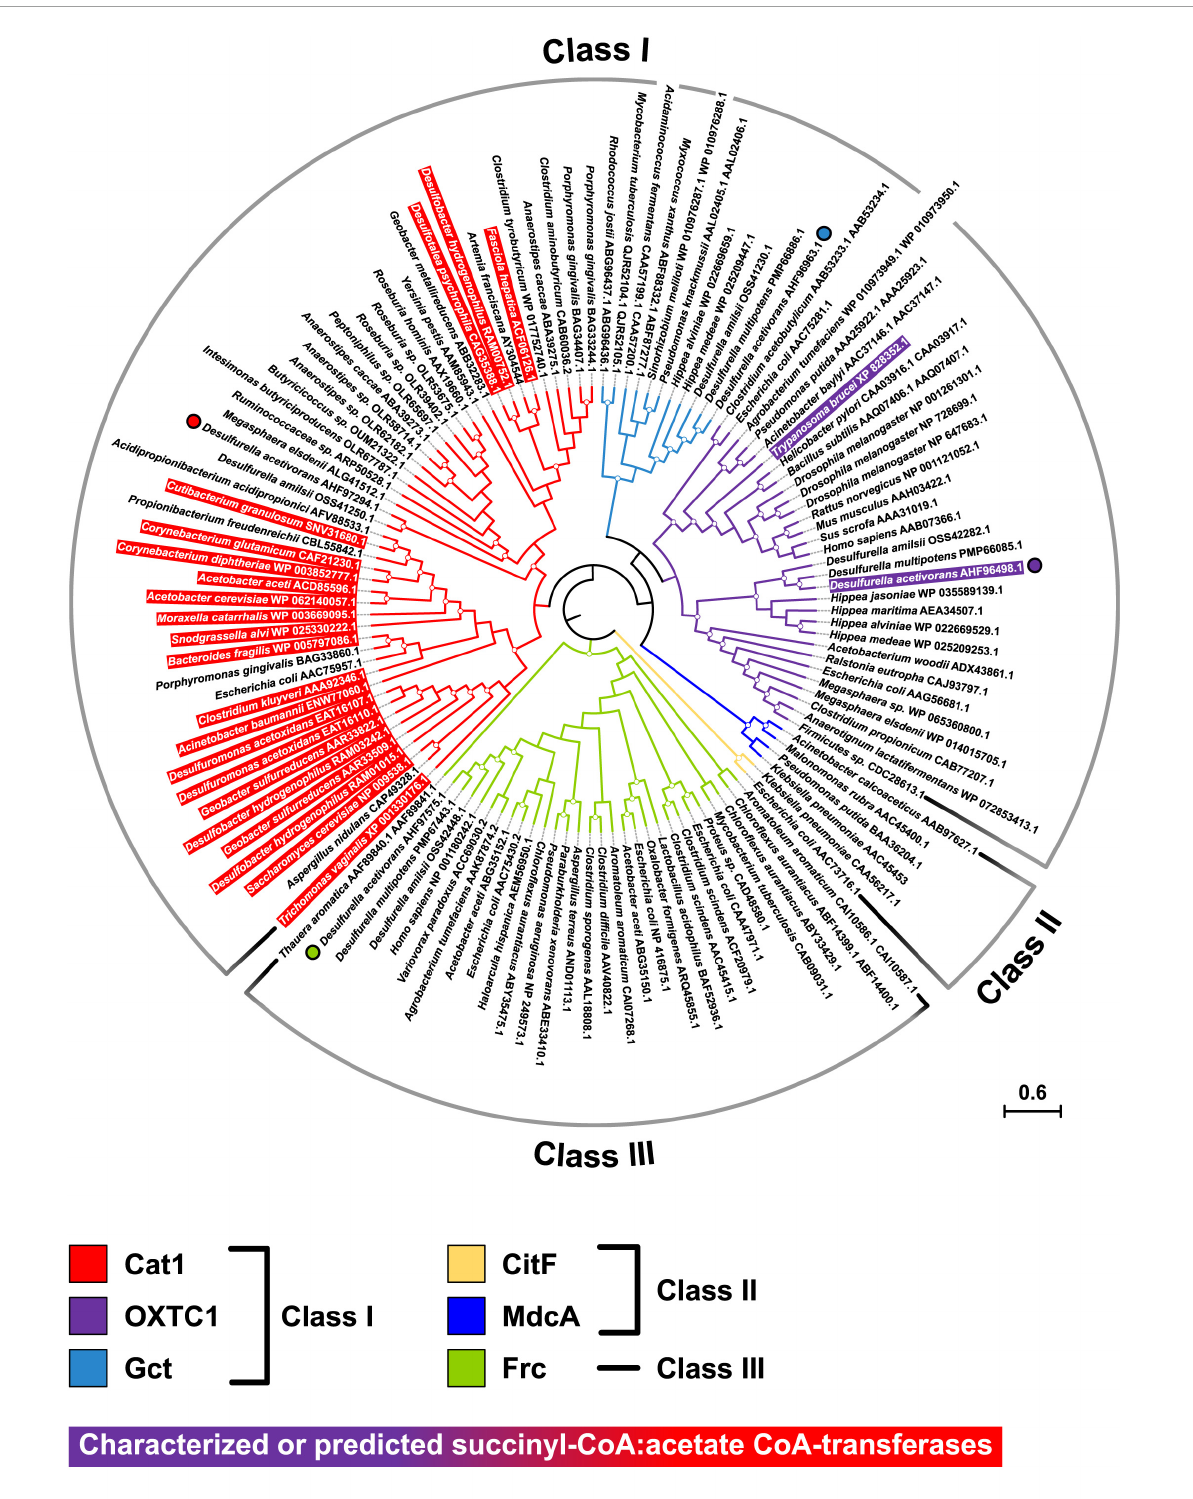
FIGURE3 Phylogenetic tree of CoA-transferases constructed by maximum likelihood algorithm. The scale bar represents a difference of 0.6 amino acid substitutions per site. The percentage bootstrap values for the clade of this group were calculated in 500 replications. The clades with bootstrap values above 70% are marked with circles. The tree constructed by maximum-parsimony algorithm was similar with minor exceptions (not